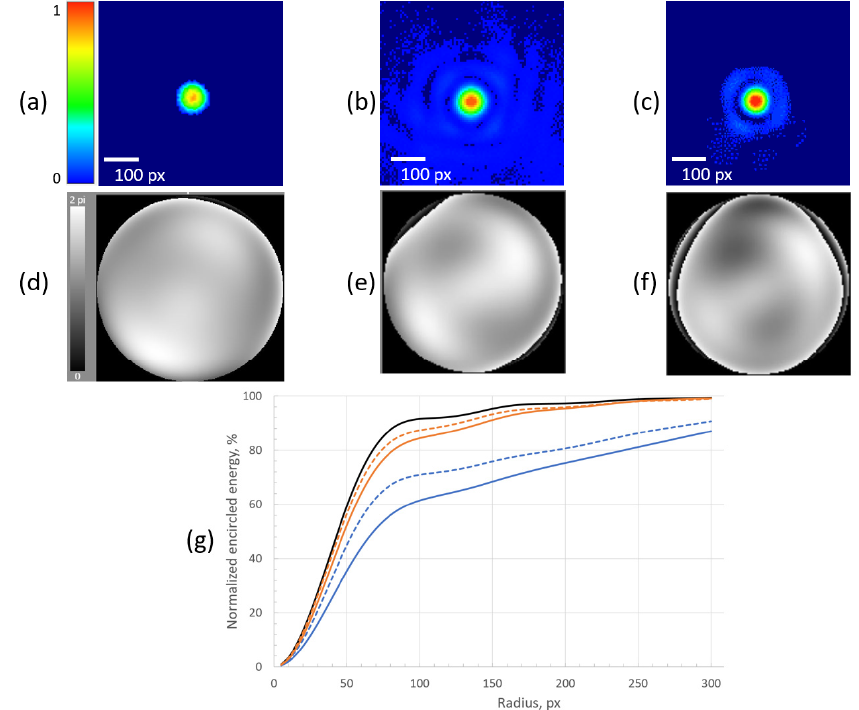
Figure 7. ( a ) Intensity distribution of the far-field focal spot obtained after the calibration procedure was done (glass cuvette contained water only). ( b , c ) Intensity distributions after optimization by means of the SLM for the concentration values 3.1 × 10 5 mm − 3 and 8.2 × 10 5 mm − 3 , correspondingly. ( d – f ) SLM patterns that were used to obtain intensity distributions of focal spots presented above. ( g ) Normalized encircled energy charts: black solid curve—without scattering medium; blue curves—with scattering medium with concentration value 3.1 × 10 5 mm − 3 before (solid curve) and after (dashed curve) focusing with the SLM; orange curves—with scattering medium with concentration value 8.2 × 10 5 mm − 3 before (solid curve) and after (dashed curve) focusing with the SLM.